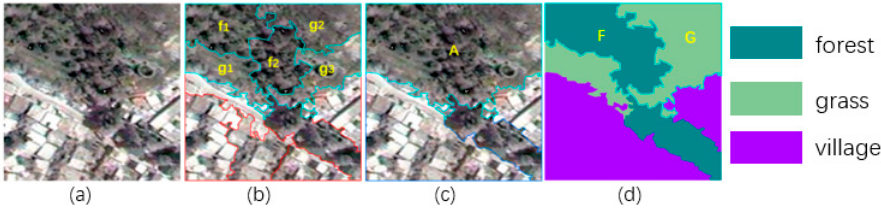
Figure 6. Comparison of the segmentation between two scales. ( a ) denotes original image; ( b ) denotes the result of small scale segmentation; ( c ) denotes the result of large scale segmentation; ( d ) denotes GT.